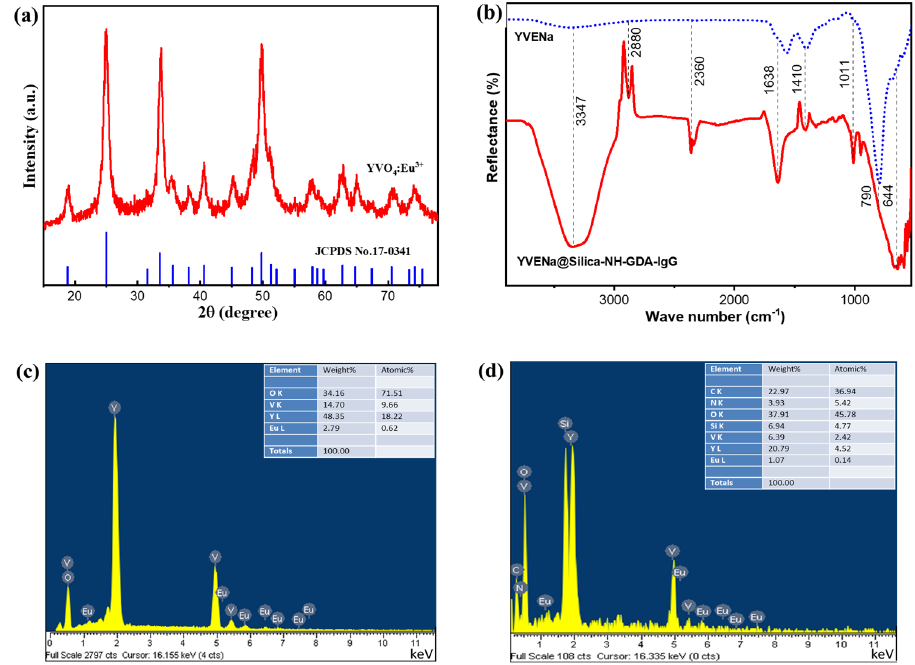
Figure 2. ( a ) X-ray diffraction pattern of the YVO 4 :Eu 3+ sample in comparison with the standard data of tetragonal-phase YVO 4 :Eu 3+ nanoparticles (JCPDS No. 17-0341) as a reference. ( b ) FTIR spectra of the YVO 4 :Eu 3+ @silica-NH-GDA-IgG sample and the YVO 4 :Eu 3+ samples. ( c ) EDX spectrum of the YVO 4 :Eu 3+ sample. ( d ) EDX spectrum of the YVO 4 :Eu 3+ @silica-NH-GDA-IgG sample.